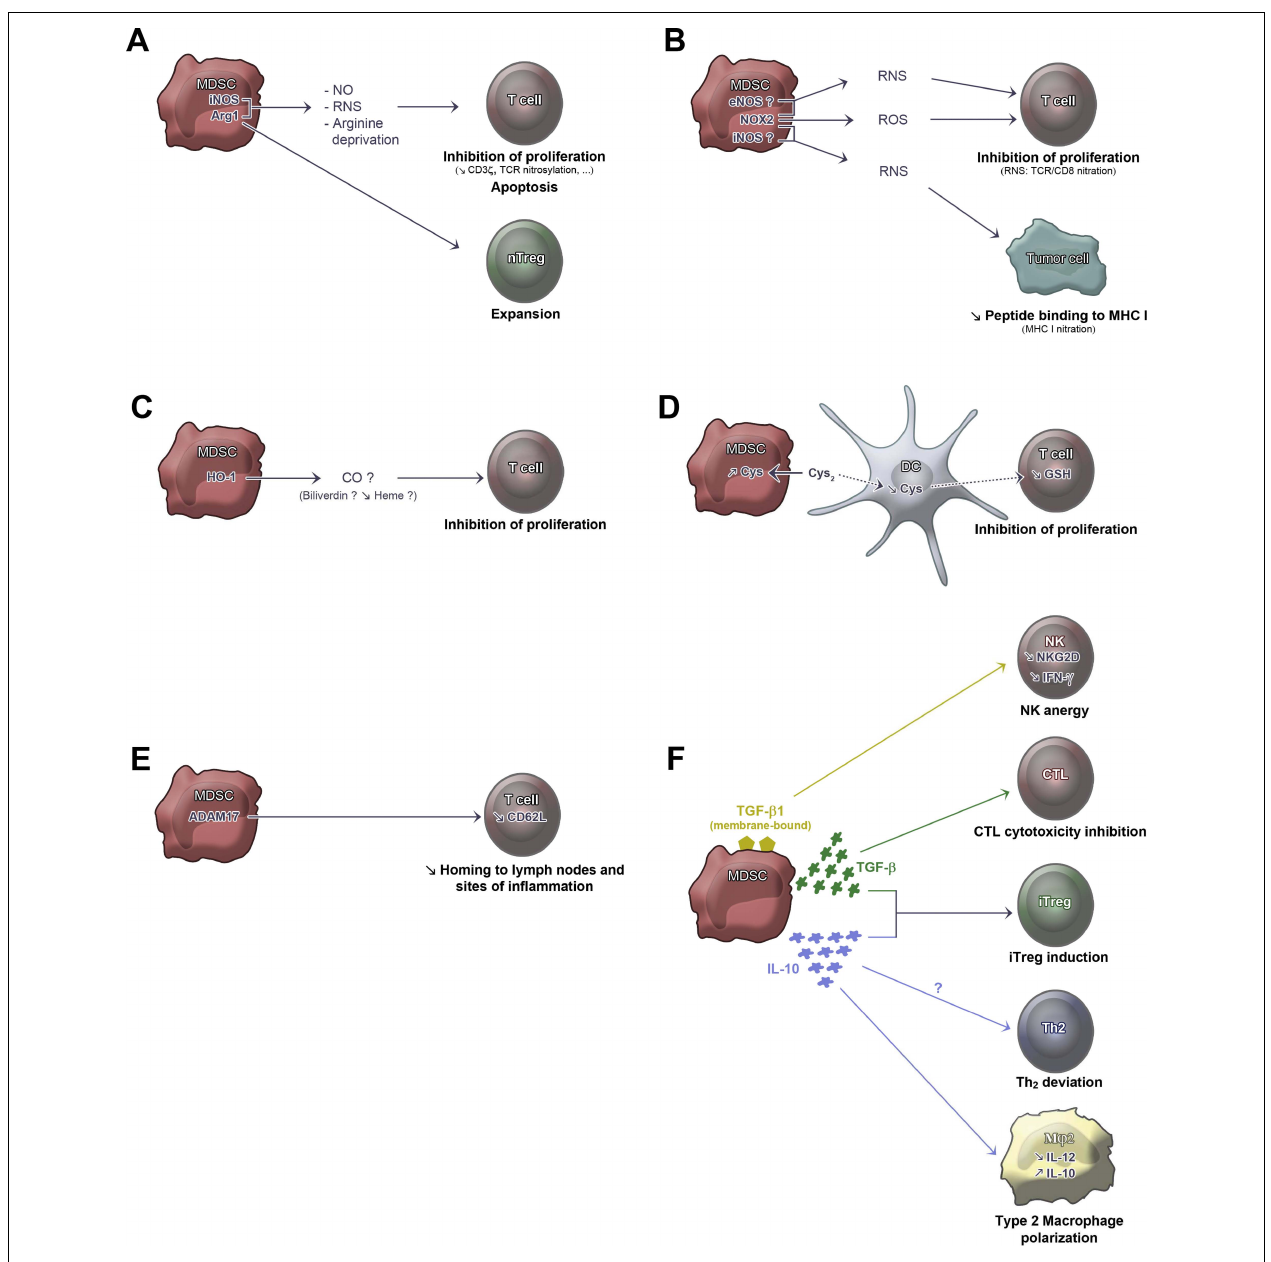
FIGURE 2 | Mechanisms of suppression by MDSC. (A) Arg1, arginase-1. Arg1 induces arginine deprivation. iNOS, inducible nitric oxide synthase. iNOS induces nitric oxide (NO) production (that can be derived into reactive nitrogen species, RNS). Arg1 activity leads to CD3 ζ down-modulation (Rodriguez etal., 2007; Highfill etal., 2010),TCR CD3 ζ nitrosylation (Nagaraj etal., 2007, 2010), and naturalTreg (nTreg) expansion (Serafini etal., 2006, 2008), while iNOS activity leads toT cell apoptosis (Brito etal., 1999; Jia etal., 2010) and inhibition ofT cell proliferation (Rodriguez etal., 2007; Cripps etal., 2010). (B) eNOS, endothelial nitric oxide synthase. NOX2, NADPH oxidase 2. The enzyme induces reactive oxygen species (ROS) production and, together with eNOS and/or iNOS activities, can induce RNS production. NOX2 leads to inhibition ofT cell proliferation through ROS production (Tacke and Kurts, 2011),TCR CD3 ζ nitration (Nagaraj etal., 2010) and MHC class I nitration (Lu etal., 2011). (C) HO-1, heme oxygenase 1.The enzyme leads to inhibition of T cell proliferation probably through CO production (DeWilde etal., 2009).